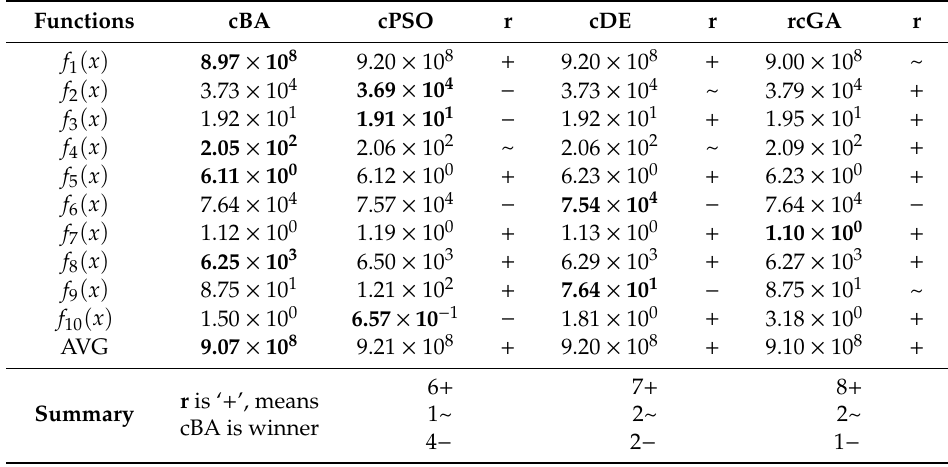
Table 4. Comparison of the outcomes of the proposed method with the other compact algorithms such as rcGA [39], cDE [40], and cPSO [39] for 10 test